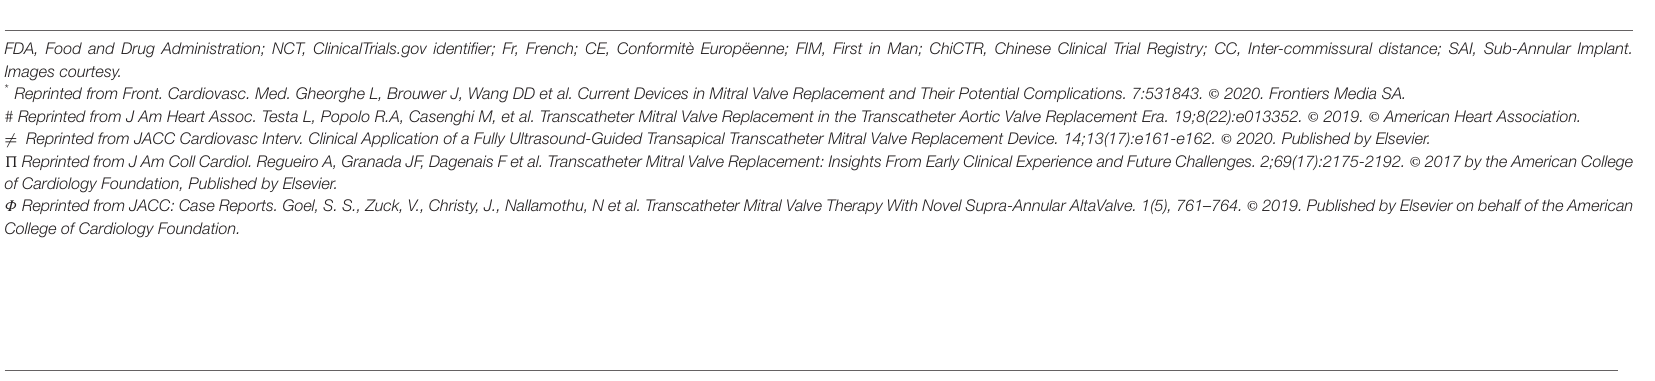
TABLE 3 | Summary of periprocedural outcome of TMVI